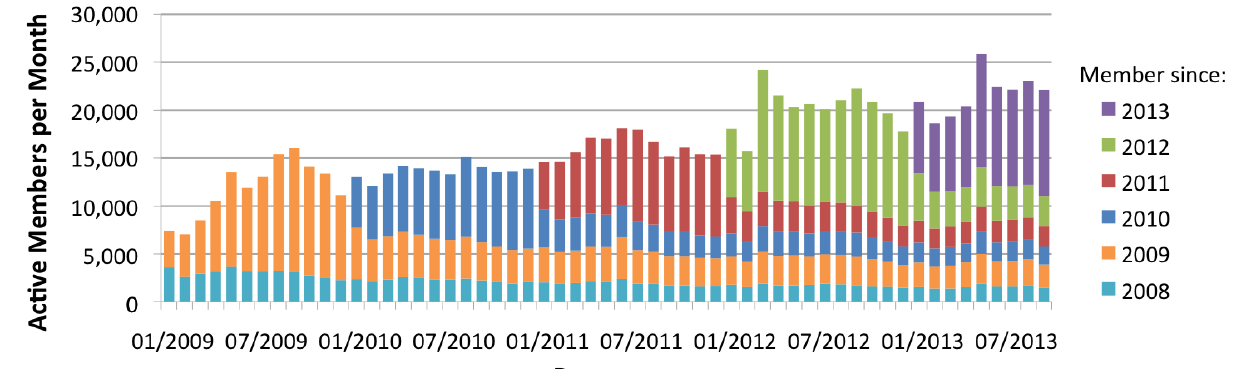
Figure 3. Active contributors per month between 2009 and